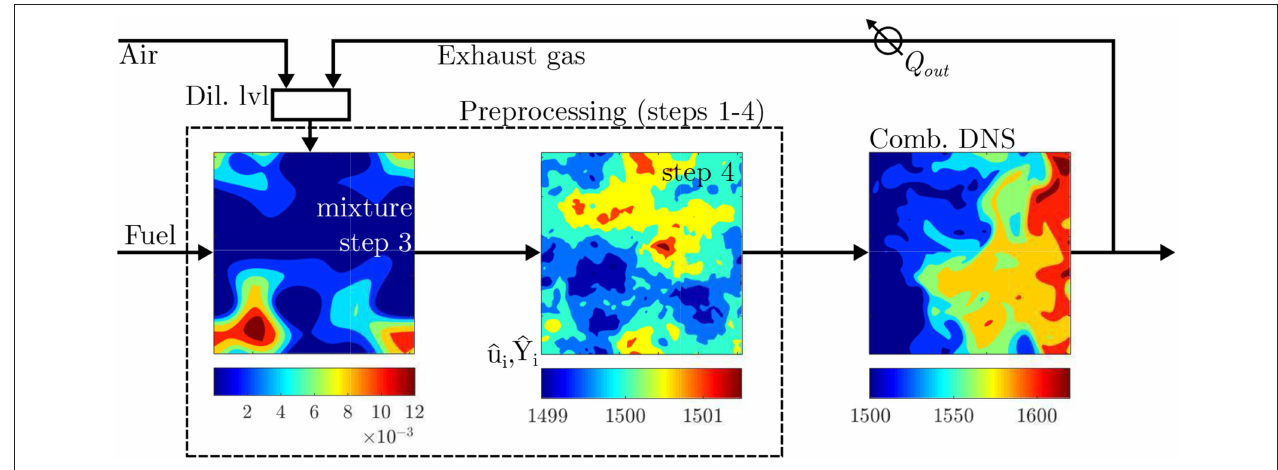
FIGURE 3 | A schematic of DNS steps followed for non-premixed MILD combustion with internal recirculation of exhaust gases, adapted from Doan et al. (2018) under a Creative Commons license.